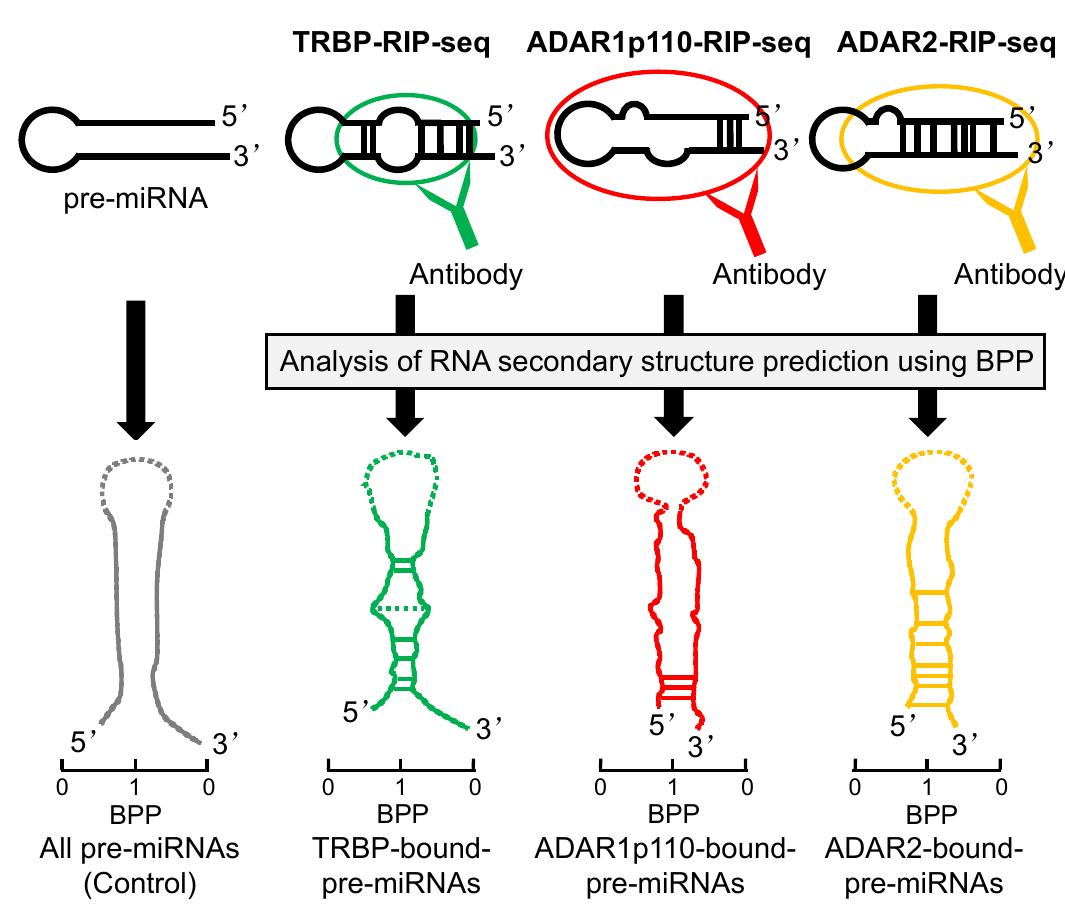
Figure 4. The pre-miRNA secondary structures preferentially bound by TRBP, ADAR1p110, or ADAR2. Secondary structures of pre-miRNAs, preferentially bound by TRBP, ADAR1p110, or ADAR2 as predicted by BPP. The pre-miRNAs bound to each dsRBP was determined by RIP-sequencing and secondary structures of pre-miRNAs are shown here schematically, modified from ref [93,97]. BPP is calculated for each base of pre-miRNAs and is a value in the range of 0 to 1; 0 indicates the low base-pairing probability and 1 indicates the high probability. The horizontal lines between 5 ′ strand and 3 ′ strand represent base-pairing, and the solid lines indicate the nucleotide positions with significantly high BPPs relative to the control and the dotted lines indicate the posi- tions with significantly low BPPs. The BPP of the terminal loop of pre-miRNA was not calculated and shown in dotted line.